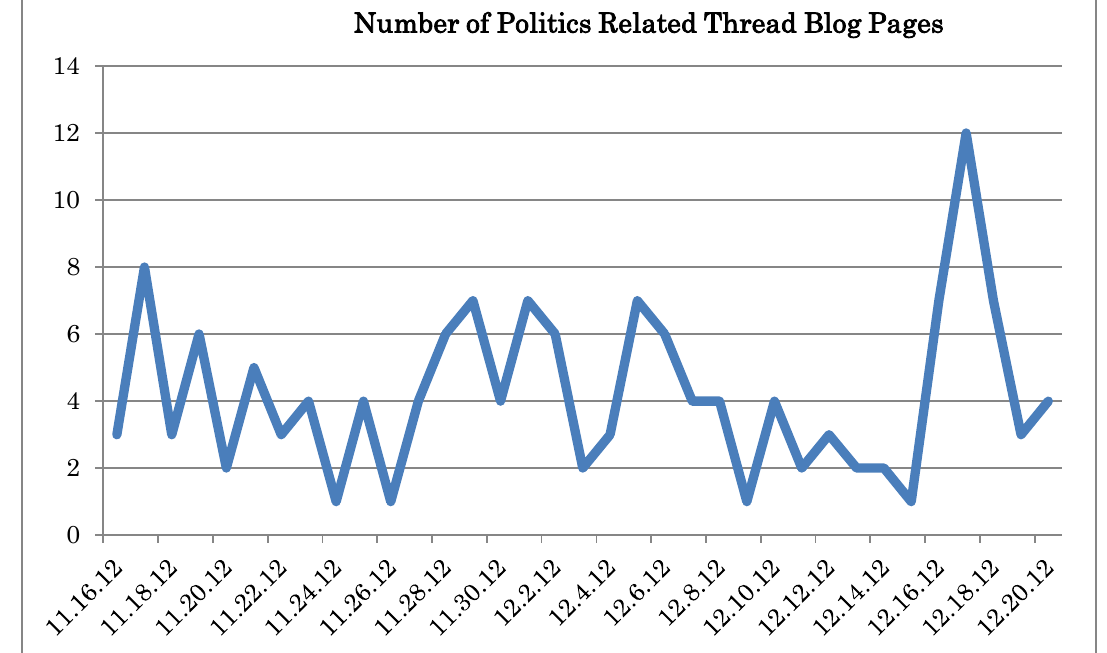
Figure 2. The Number of Politics Related Titles during Nov. 16 ~ Dec. 20, 2012 on MT2 During the time span of 35 days of this analysis, the top 50 daily thread blog pages of the Matome Saito aggregators from each day were selected. The reason for selecting these 50 blog pages is because they are the first 50 titles of aggregated information optimized for smartphones. These are the blogs that are most viewed by all the users of Matome Saito aggregator